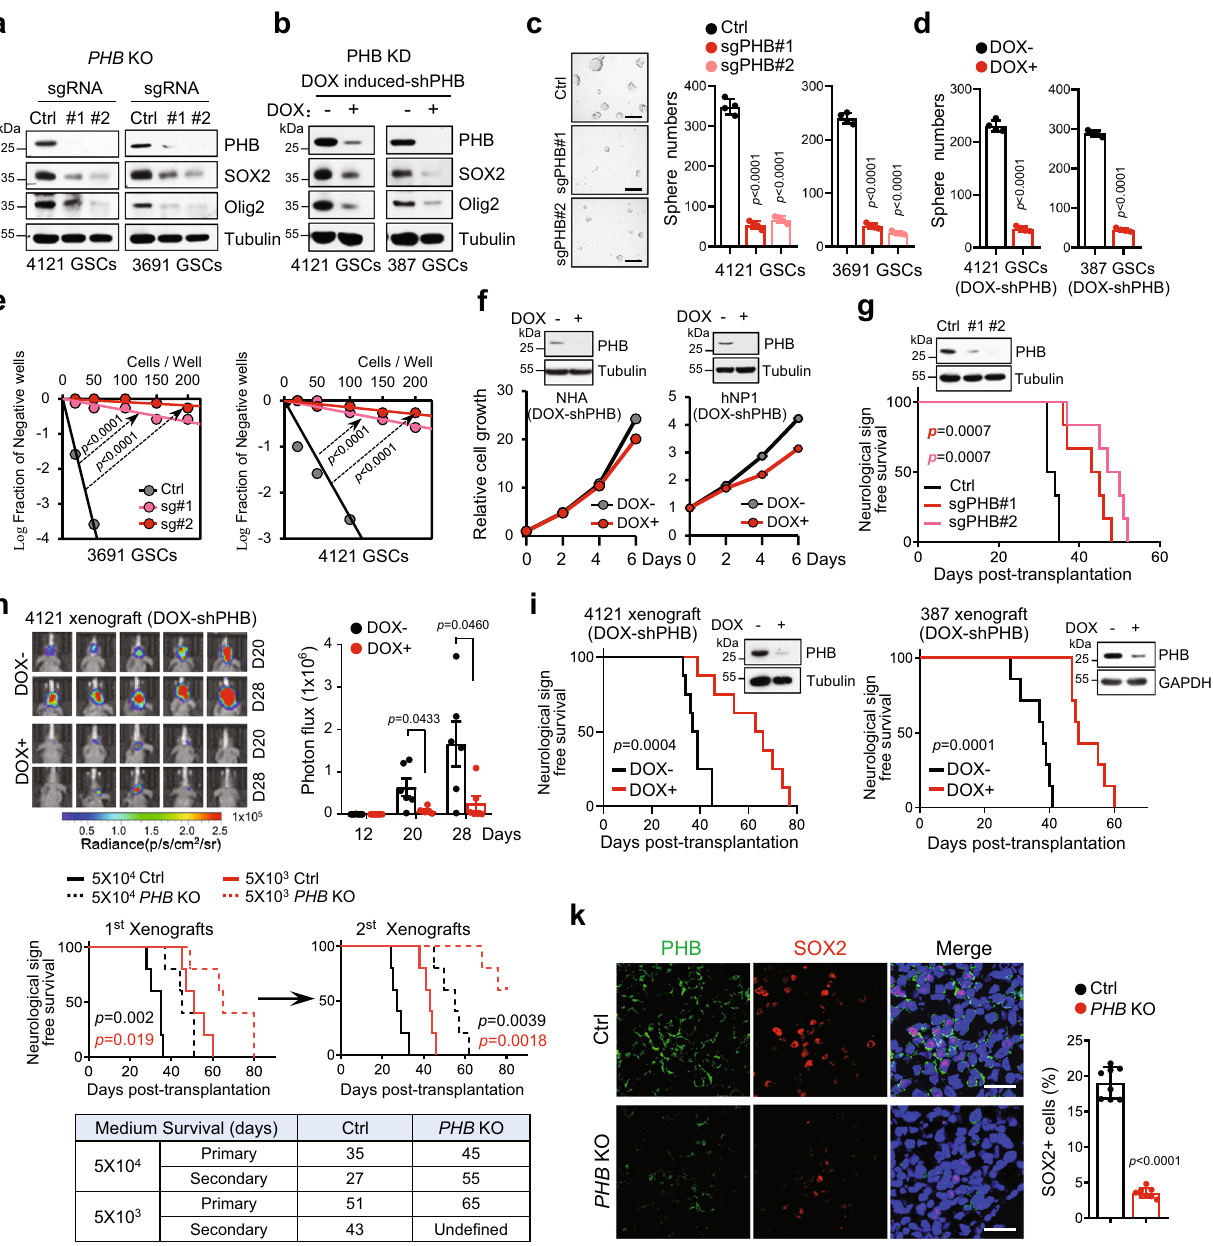
Fig. 2 PHB promotes GSC self-renewal and tumor progression. a PHB knockout GSCs were generated by CRISPR-Cas9 system. IB showing levels of indicated proteins in Ctrl and PHB KO GSCs. b GSCs stably transduced with Tet-on-inducible-shPHB were treated with DOX (100 ng/ml) or vehicle control. Expression of indicated proteins were assessed by IB. c , d Quanti fi cations of tumorsphere numbers (2000 cells/well) formed by Ctrl or PHB KO GSCs ( c , right), or control or PHB inducible-KD GSCs ( d ) (mean ± SD, n = 4, biologically independent experiments). Representative images of tumorspheres are shown ( c , left). Scale bar, 100 μ m. e In vitro extreme limiting dilution assays (ELDAs) show that PHB KO decreased the frequency of tumorsphere formation in GSCs. f Inducible-KD of PHB had limit effects on cell growth of NHA (left) and hNP1 (right), as measured by cell viability assay. g` Ctrl or PHB KO 4121 GSCs (5 × 10 4 /mouse) were implanted into the brains of nude mice (nu/nu, n = 6). Kaplan – Meier survival curve of mice is shown (Log-rank Mantel – Cox test). IB showing the ef fi ciency of PHB KO in xenografts (top). h , i GSCs transduced with Tet-on-inducible-shPHB and Luciferase reporter were implanted into the brains of nude mice (nu/nu). Mice were treated with vehicle control or DOX (2 mg/ml in drinking water) to induce expression of shPHB from day 0. GBM xenografts (4121 GSCs) were tracked by bioluminescence ( h , left). Bioluminescent quanti fi cation of tumor growth is shown ( h , right) (mean ± SEM, n = 6, biologically independent mice). Kaplan – Meier survival curves of mice are shown ( i ) (4121 GSCs, n = 8; 387 GSCs, n = 7; Log-rank Mantel-Cox test). IB showing the ef fi ciency of PHB knockdown in the xenografts (top). j The in vivo serial transplantation assay shows that PHB KO inhibits GSC self-renewal in vivo. Kaplan – Meier survival curves of mice implanted with indicated GSCs (4121) are shown (top) ( n = 5; Log-rank Mantel – Cox test). Summary of mice medium survival in the serial transplantation assay is shown (bottom). k Co-IF staining of PHB (green) and SOX2 (red) in GBM xenografts derived from Ctrl or PHB KO GSCs (4121). Quanti fi cations of SOX2 + cells are shown (right) (mean ± SD, images n = 8, from 4 biologically independent samples). Nuclei were counterstained with Hoechst (blue). Scale bars, 40 μ m. Unpaired two-sided Student ’ s t- test ( c – e , h ), Welch ’ s two-sided t- test ( k ). Source data are provided as Source Data fi